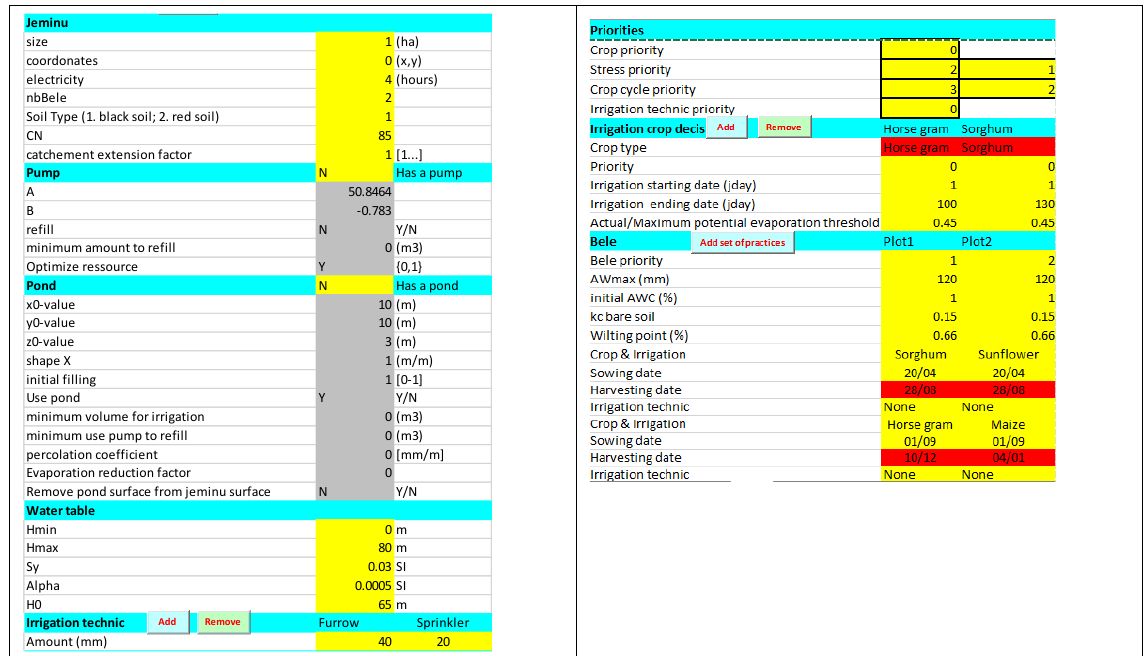
Figure A3. Parameters of Sc0.